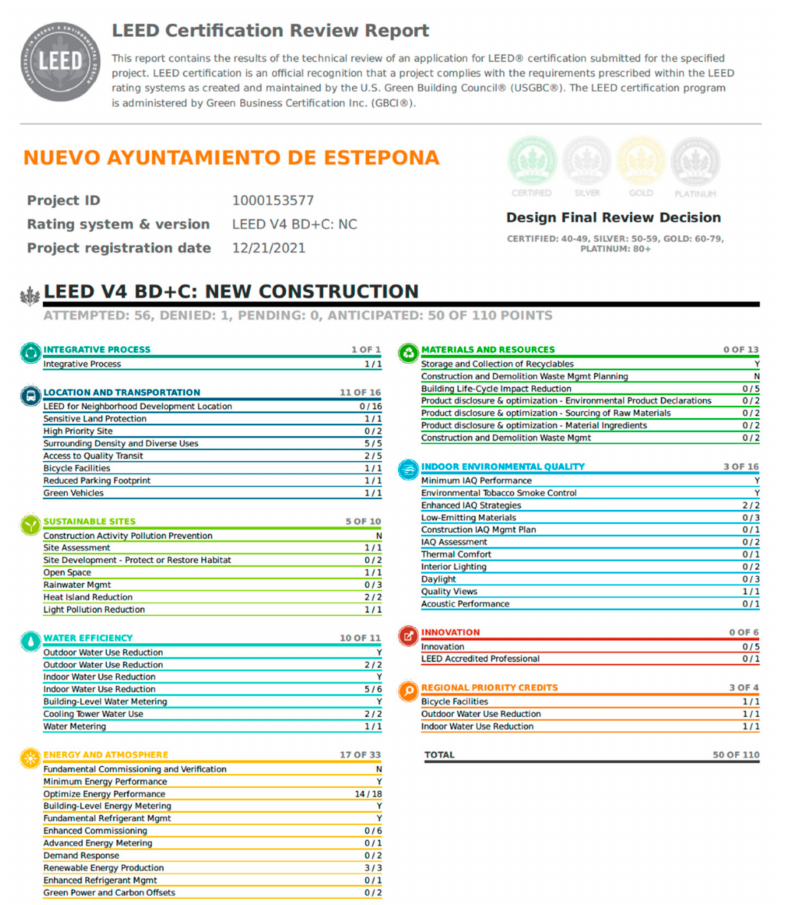
Figure 3. LEED Certification Review Report accreditation document, provided by GBCe in the design phase, prior to the commissioning of the reference work, case study “New City Hall of Estepona”, in accordance with the rating systems created and maintained by the U.S. CITY HALL OR TOWN HALL, PREGUNTAR Green Building Council ® (USGBC ® ). The LEED certification programme is administered by Green Business Certification Inc (GBCI ® )